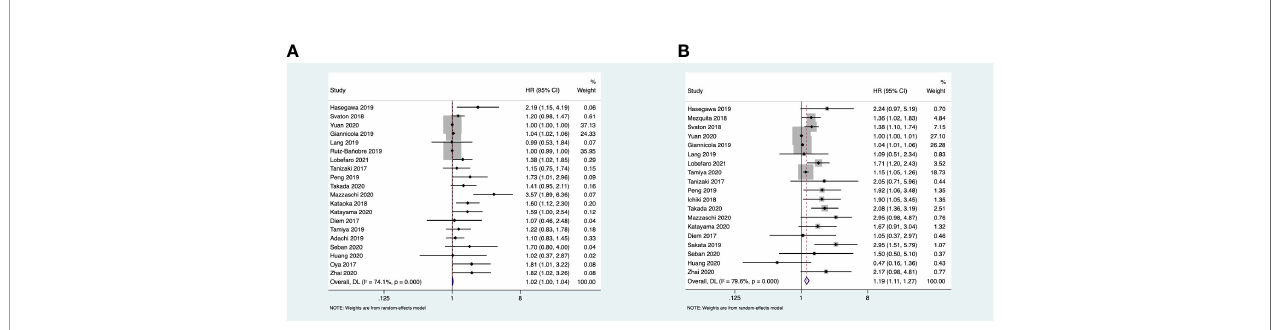
FIGURE 2 | (A) Forest plots of the association between pretreatment lactate dehydrogenase (LDH) and progression-free survival. (B) Forest plots of the association between pretreatment LDH and overall